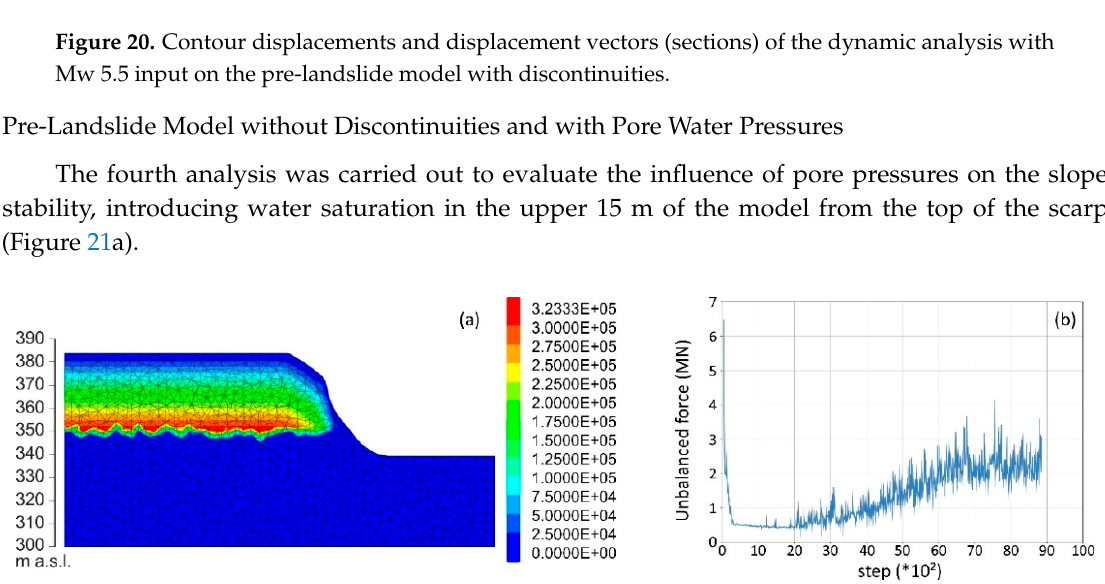
Figure 21. ( a ) Detail of pore pressures in the pre-landslide model. ( b ) Maximum unbalanced force in the model.